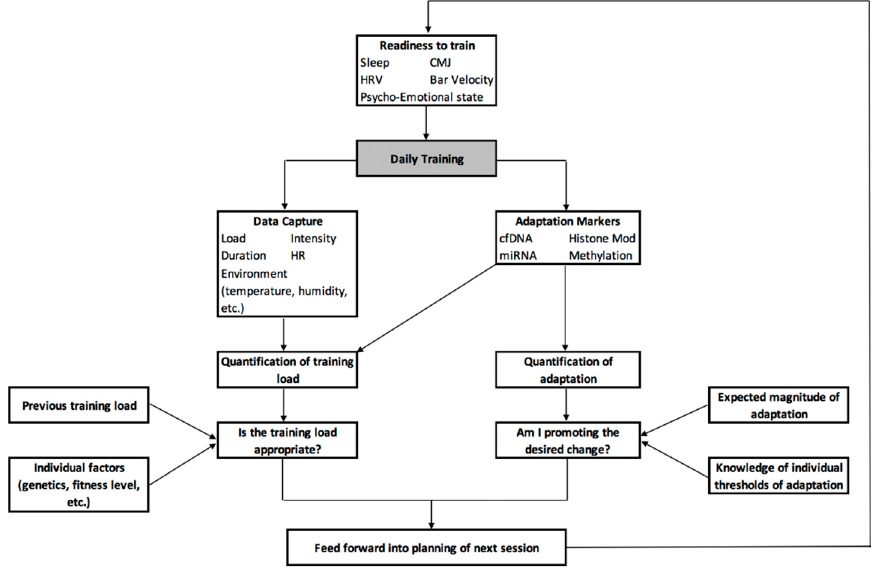
Figure 3. A framework for the implementation of various emerging technologies to enhance daily training practice. training